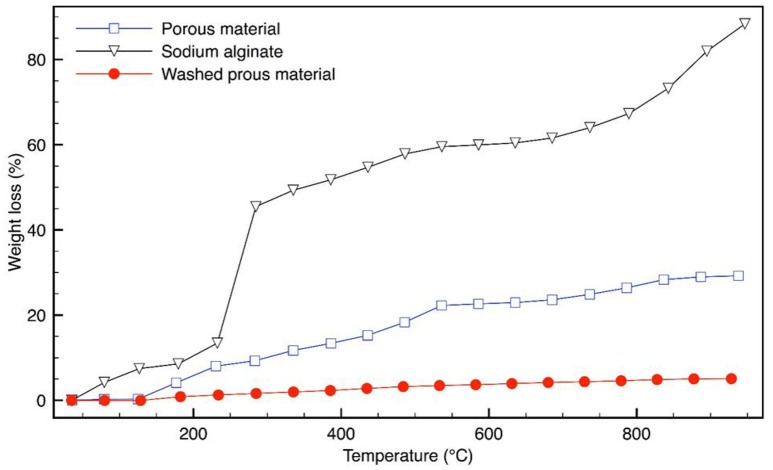
TGA made on pure SA and the obtained porous materials after and before washing.